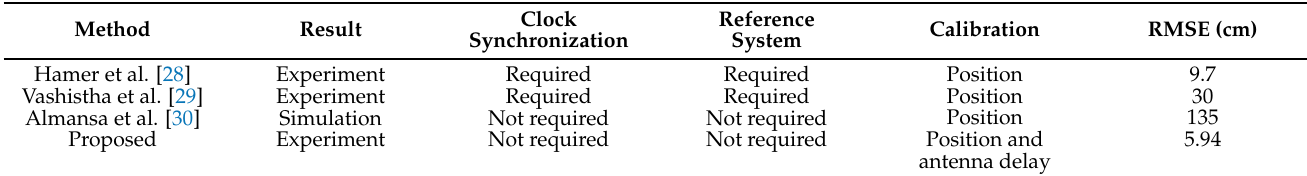
Table 3. Comparison of auto-calibration methods for UWB-based anchor